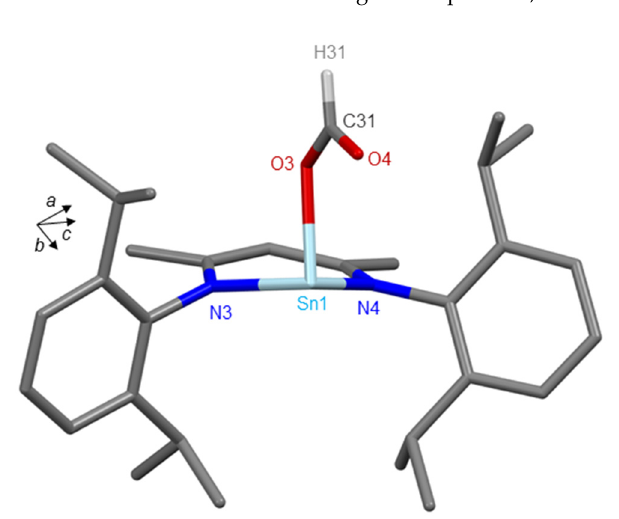
Figure 11. Molecular structure of 8 , adapted from [62] (MERCURY view). Hydrogen atoms are omitted for clarity except that of the formate group (Sn light blue, O red, N dark blue, C grey, H white).